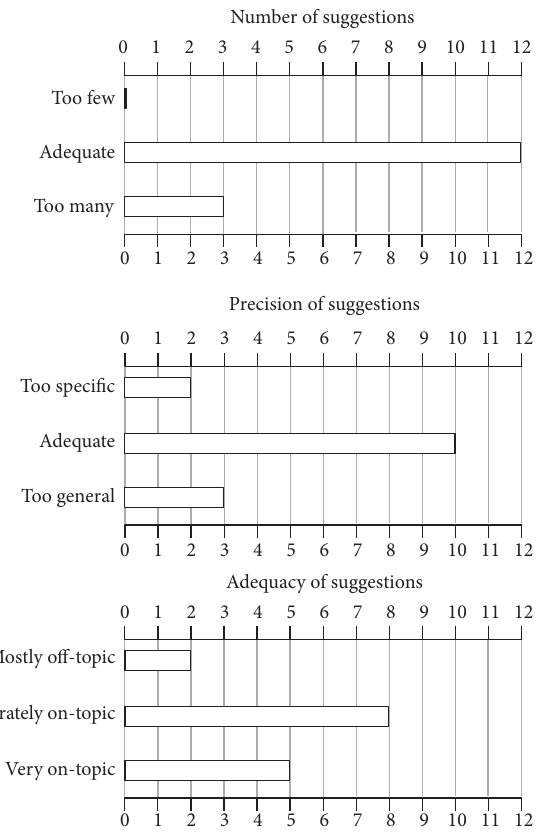
Figure 6: Quality of suggestions according to study